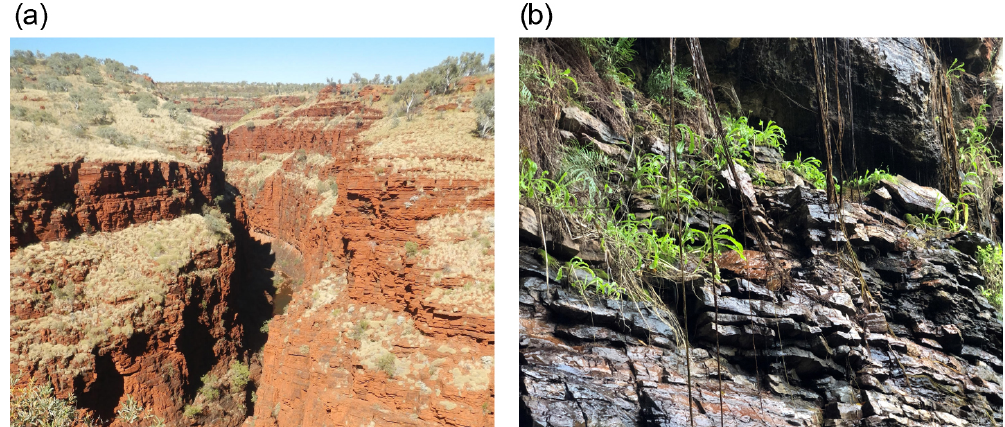
Figure 9. Photos showing (a) a river pool persisting within a substantially incised gorge, suggesting regional groundwater outflow supports pool persistence, and (b) visible groundwater outflow from an exposed rock face above a persistent river